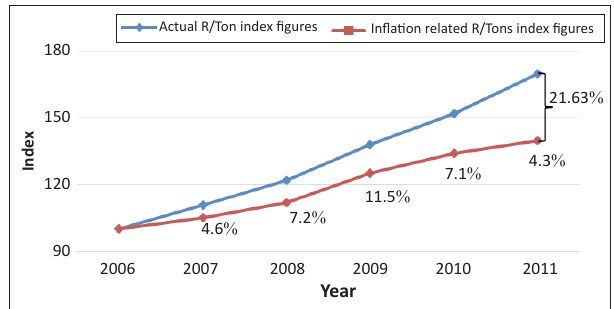
FIGURE 8: Actual and inflation-related (rail transport) rand/ton rates.